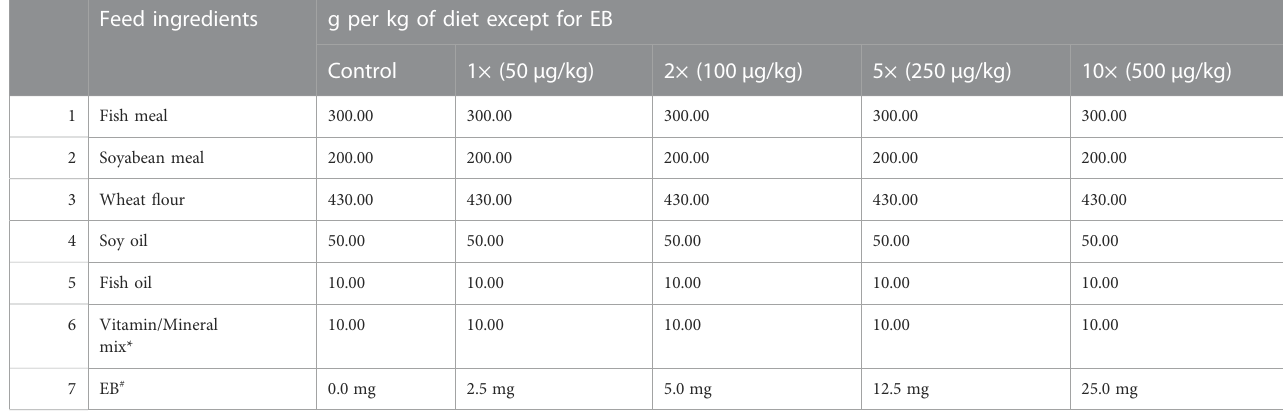
*Composition of vitamin-mineral mix (quantity/kg mix). Vitaminsources:Thiaminhydrochloride,1.0g;ribo fl avin,1.5g;pyridoxinehydrochloride,1.0g;cyanocobalamine,0.002g;nicotinicacid,1.0g;folicacid,0.2g;myo-inositol,50.0g;D-biotin,0.1g; calcium pantothenate, 2.0 g; L-ascorbyl-2-triphosphate, 50.0 g; retinal acetate, 0.075 g; cholecalciferol, 0.006 g; cellulose 393.117 g, tocopherol acetate, 0.1 g and choline chloride, 1.0 g. Mineral sources: Calcium carbonate, 50 g; magnesium oxide, 124.0 g; CaHPO 4 .2H 2 O, 200.0 g; ferric citrate, 20.0 g; potassium iodide, 0.4 g; zinc sulphate, 4.0 g; copper sulphate, 3.00 g;